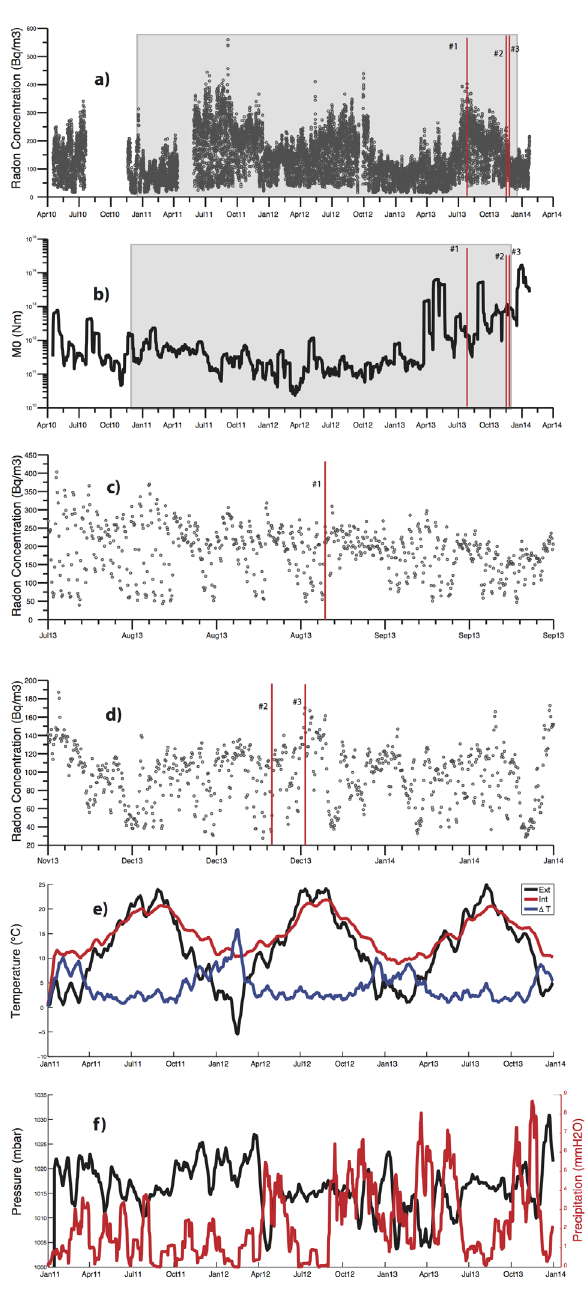
Figure 3. (a): Radon time serie from PTRL station between April 2010 and January 2014 (radon in counts/115 min). (b): 15-days mov- ing averaged time serie of cumulative seismic moment release M 0 in the same time-window of panel (a). The transparent gray rectan- gles represent the time-window we selected for our analysis. Verti- cal red lines in panels (a) and (b) represent the occurrence of the 3 ≥ 3.7 during the period (see Table 1) we selected for earthquakes M l our analysis. (c): an enlarged view of panel (a) of ± 40 days around earthquake #1 (vertical red line) of Table 1. (d): the same as in panel (c) but of about ± 40 days around earthquakes #2 and #3 (vertical red lines) of Table 1. (e): 15-days moving averaged external tem- perature (black), internal temperature (red) and their difference (blue) between January 1, 2011 and December 31, 2013. (f): 15-days moving averaged pressure (black) and precipitation (red) between January 1, 2011 and December 31,